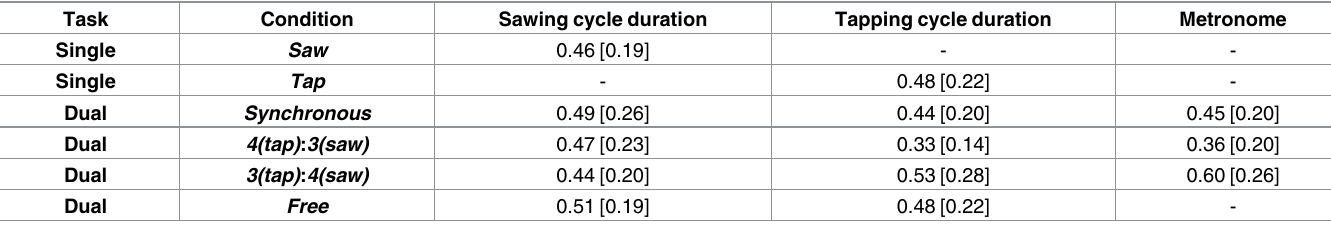
Table 1. Cycle durations across all experimental conditions. This table presents the median[IQR] for the single and dual movement tasks for both, tap- ping and sawing, as well as the metronomebeat for the three conditions in which tappingwas performed to match the set beat of a metronome.